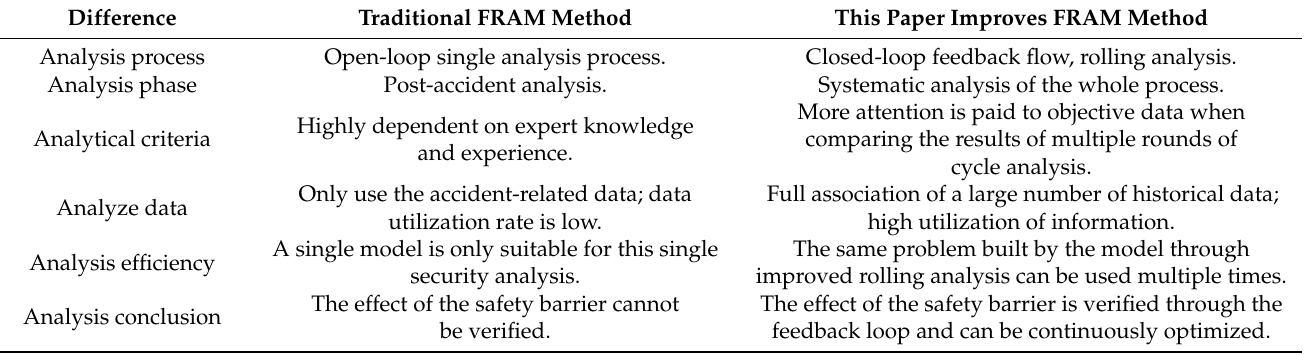
Table 17. Comparison and analysis of the model